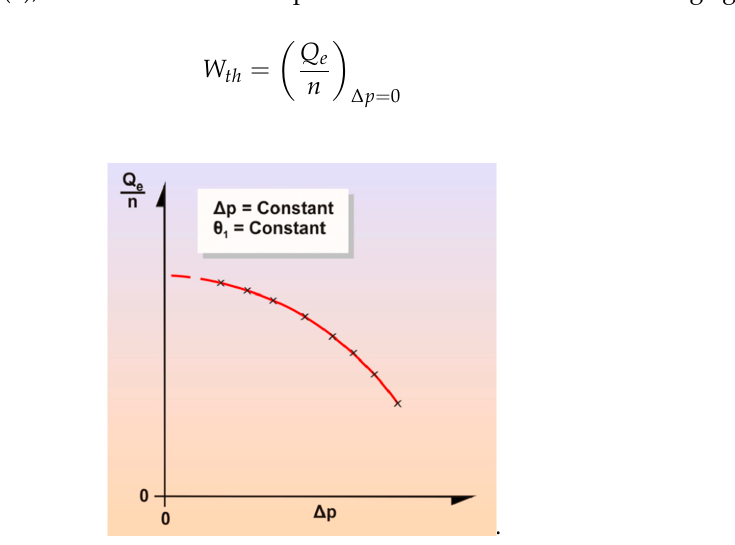
Figure 5. The piston displacement W th = Q e /n vs. the pressure difference Δ p .